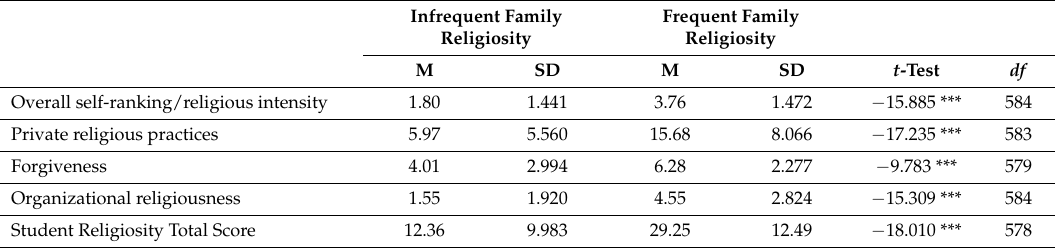
Table 4. Student religiosity by family religiosity (frequency).